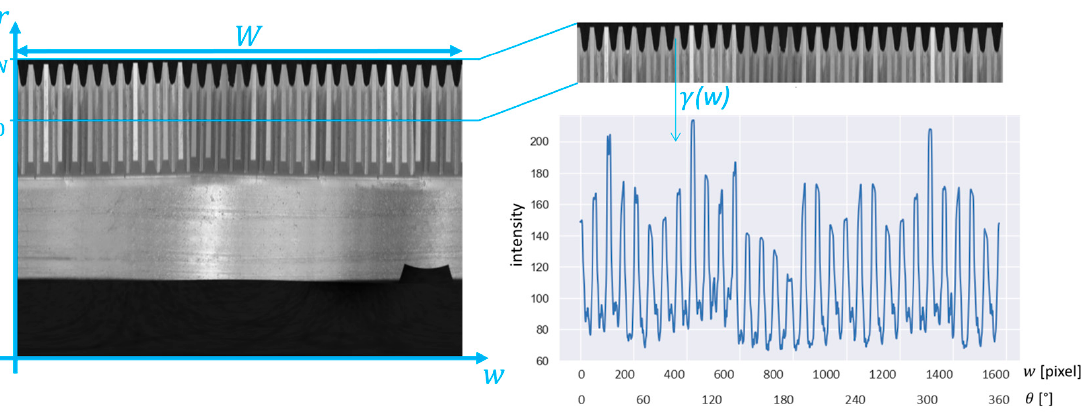
Figure 4. Procedure for the extraction of the stripe from the Cartesian picture and generation of the pseudo signal from the stripe in the case of a gear wheel with 30 teeth.